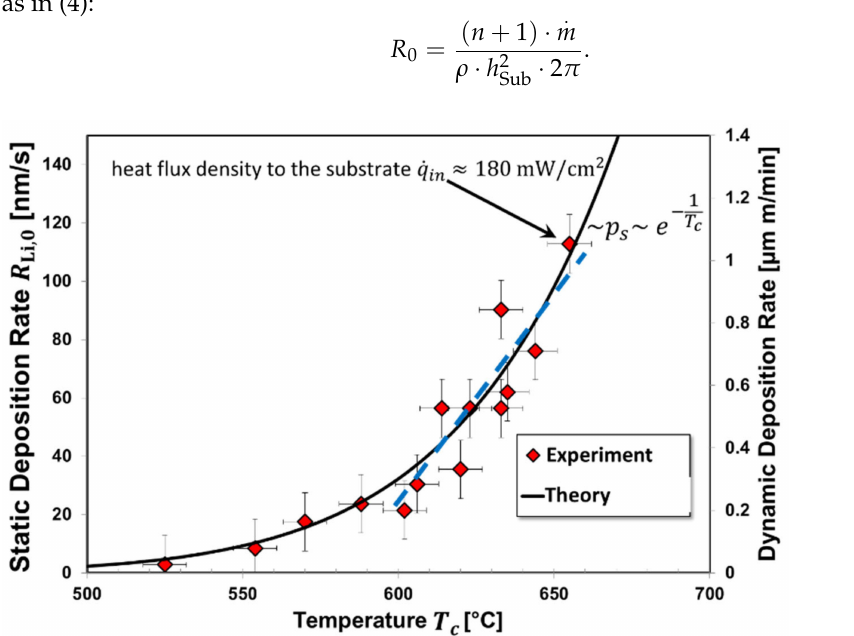
Figure 4. Measured static deposition rate of Li (left ordinate) and corresponding determined dynamic deposition rate (right ordinate) at a process pressure of 3 · 10 − 5 mbar. The black solid curve represents data determined from the saturation vapor pressure of lithium and the geometric conditions of the coating facility according to (4) and (5). In the temperature range of T c = 600 − 650 ◦ C, a sectional linear fit can be approximated by the blue dashed